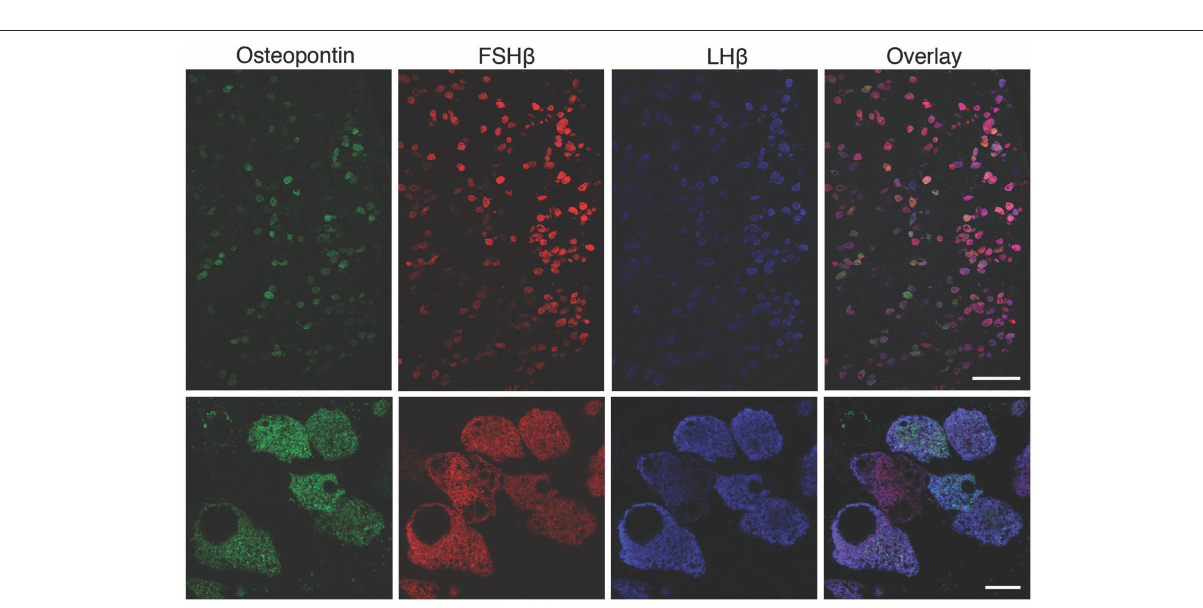
FIGURE 5 | Triple immunofluorescence labeling for OPN (green), FSH β (red), and LH β (blue) in adult male rat pituitary tissue. Low magnification images (upper row) show that all OPN-positive cells were also LH β -positive; most of the OPN-positive cells are both FSH β and LH β -positive. However, OPN was not visible in all gonadotrophs. Scale bar: 100 µ m. High -magnification of triple immunofluorescence labeling for OPN, FSH β and LH β (bottom row) shows a cluster of gonadotroph cells, most of which show immunoreactivity for all three markers. Scale bar: 10 µ